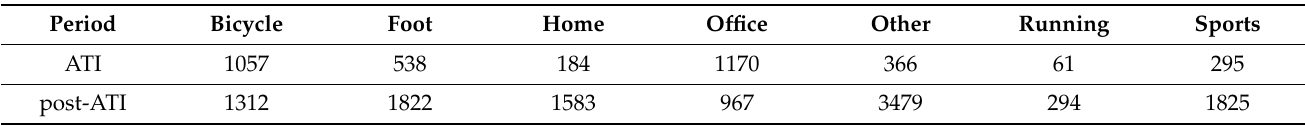
Table 3. Number of instances for each outdoor activity during the ATI period and in the post-ATI period.